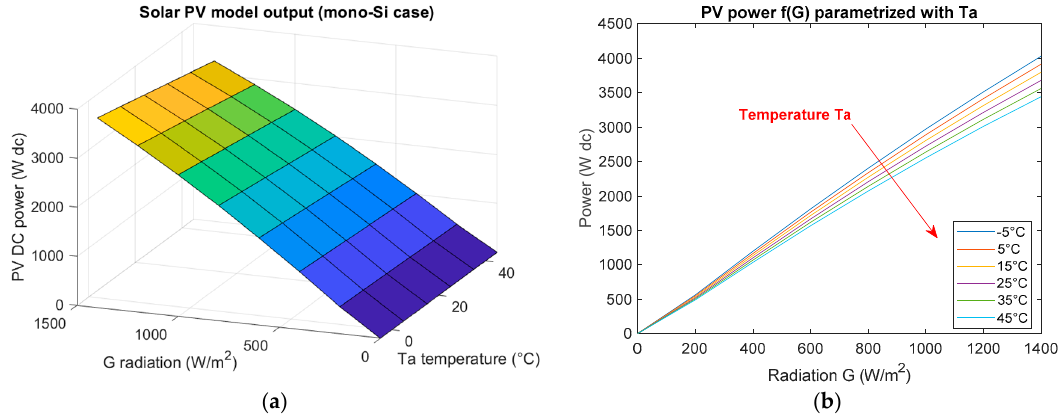
Figure 3. (a) Solar PV modelling; (b) PV power output vs temperature and radiation (model).